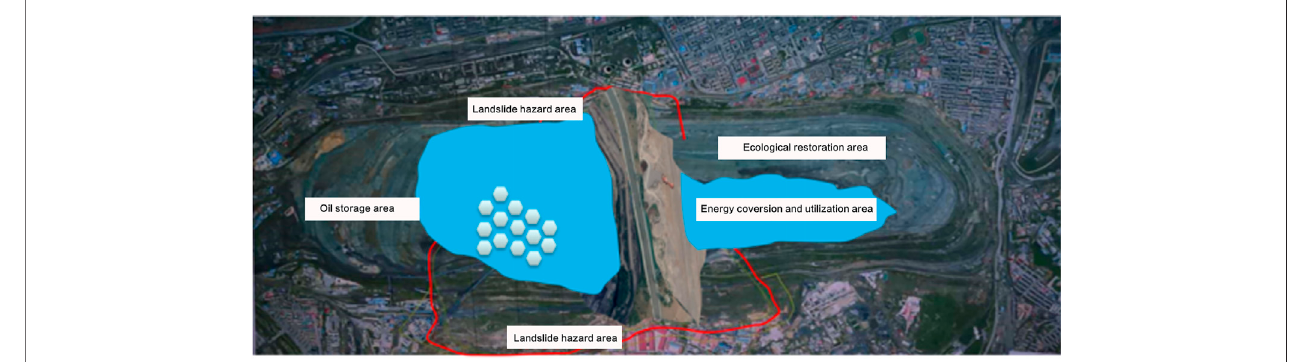
FIGURE 4 | PHES with gravity dam reinforcement mode in West open-pit